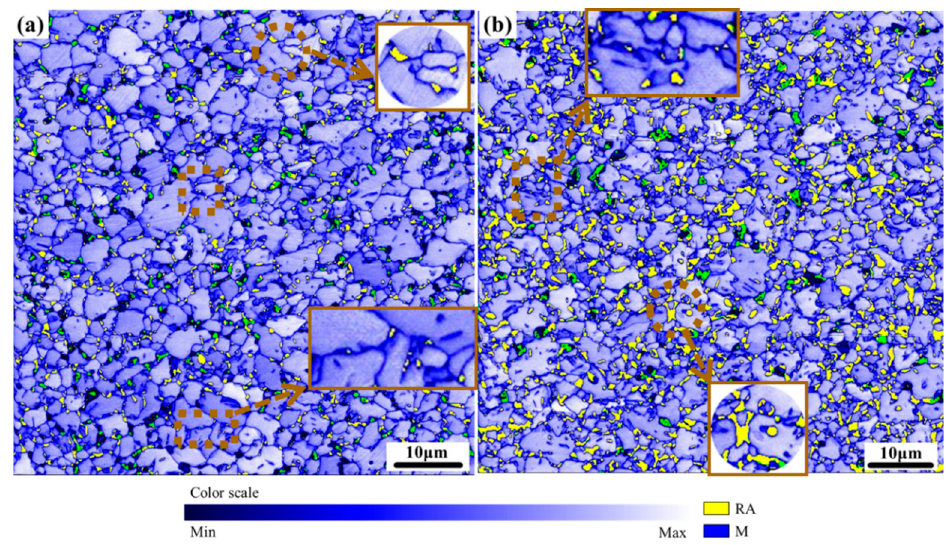
Figure 9. Combine band slope map of bcc and phase map of RA: ( a ) 340 ◦ C and ( b ) 370 ◦ C. Where lighter color is ferrite, and darker color is martensite, and residual austenite is yellow and green.